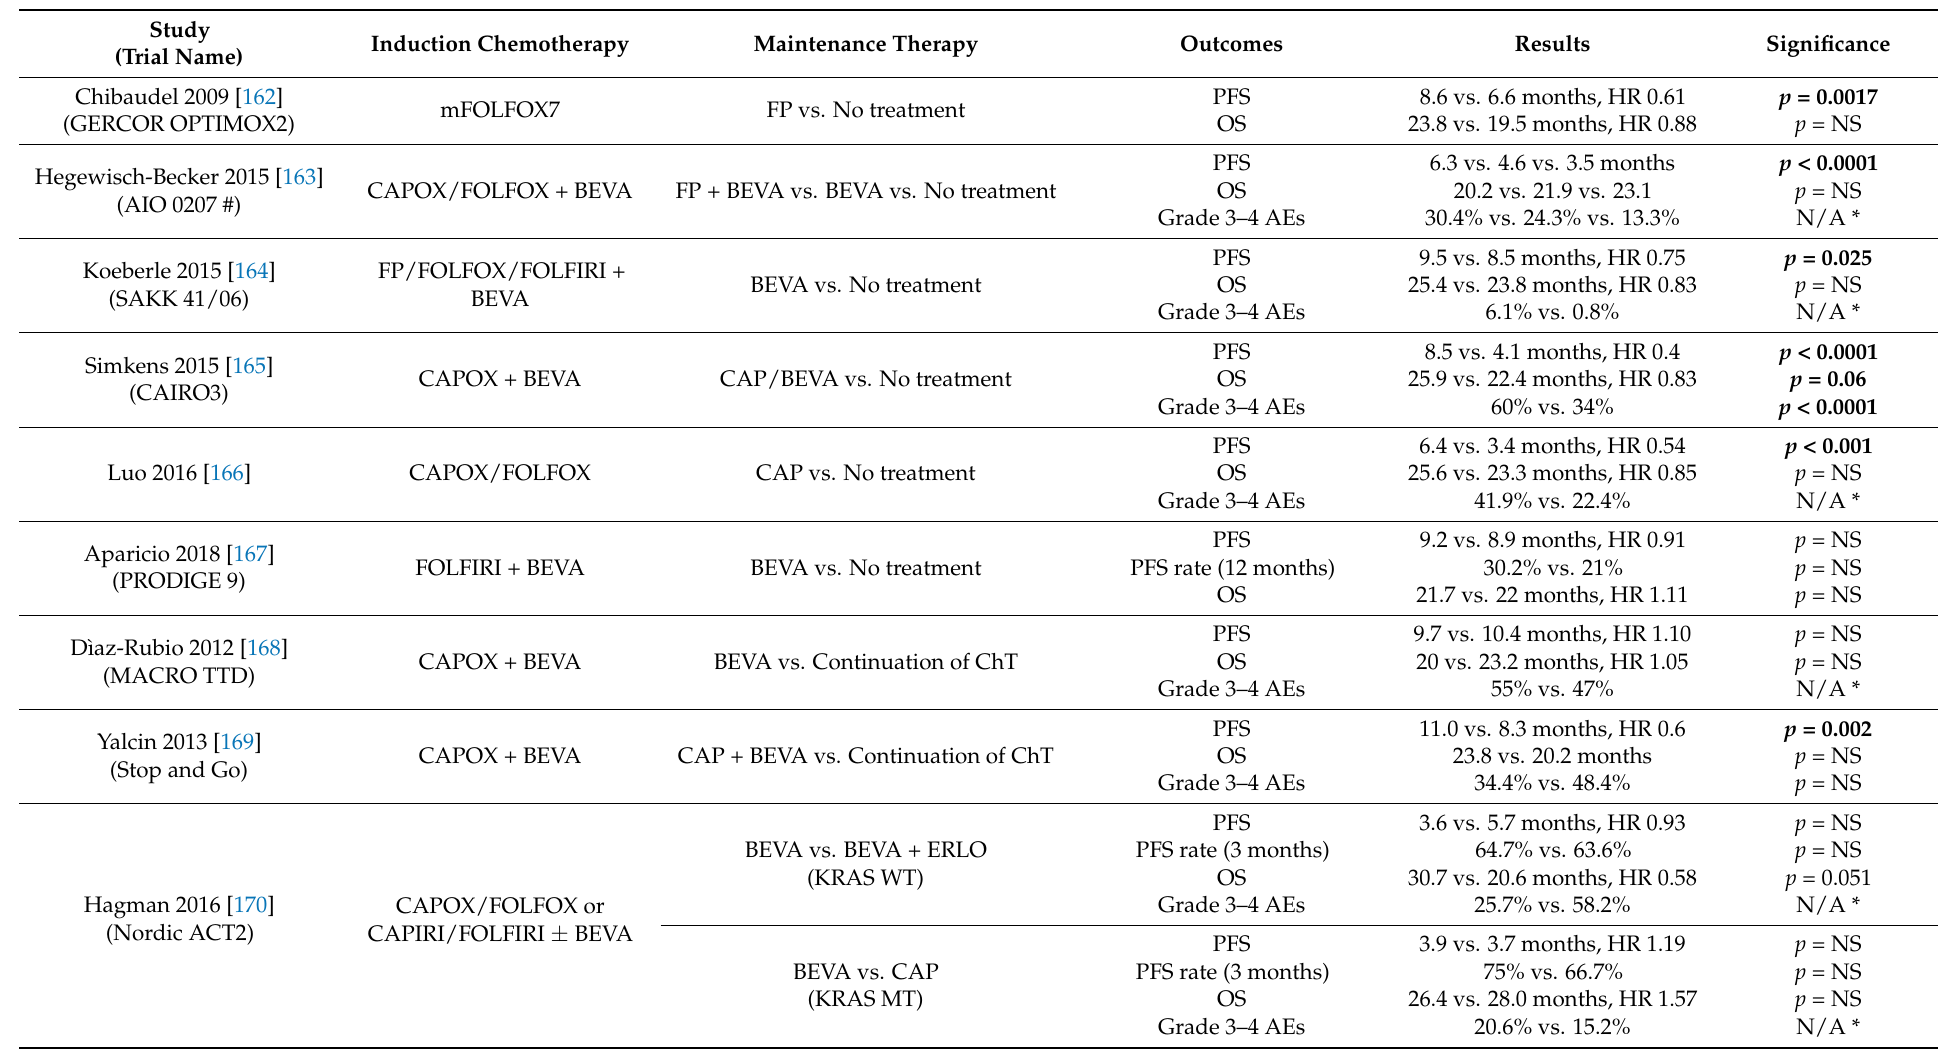
Table 4. Trials on Different Regimens for Maintenance